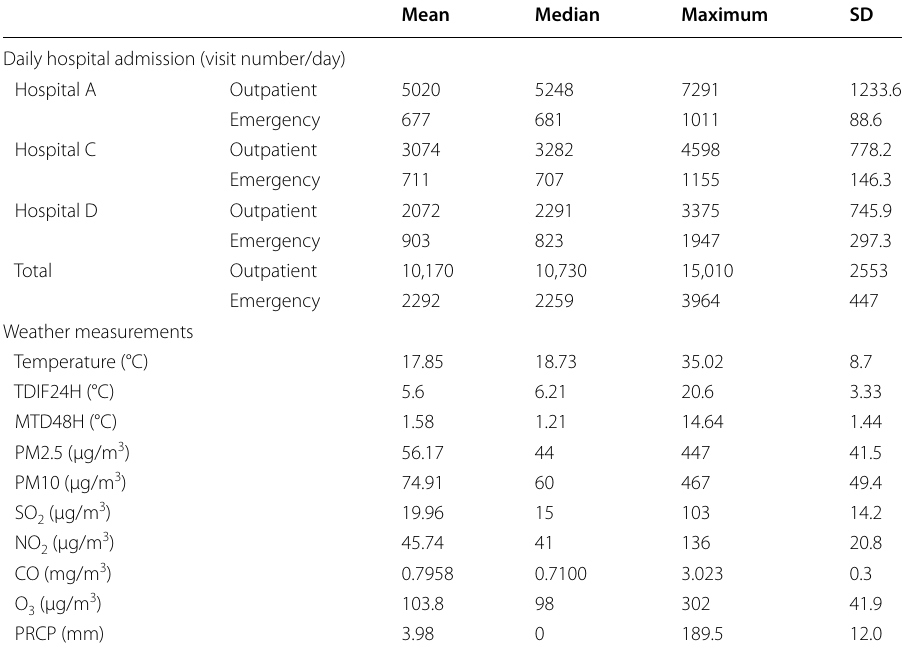
TDIF24H is the difference of temperature in 24 h MTD48H is the absolute value of mean temperature differences over 2 days PRCP is the daily